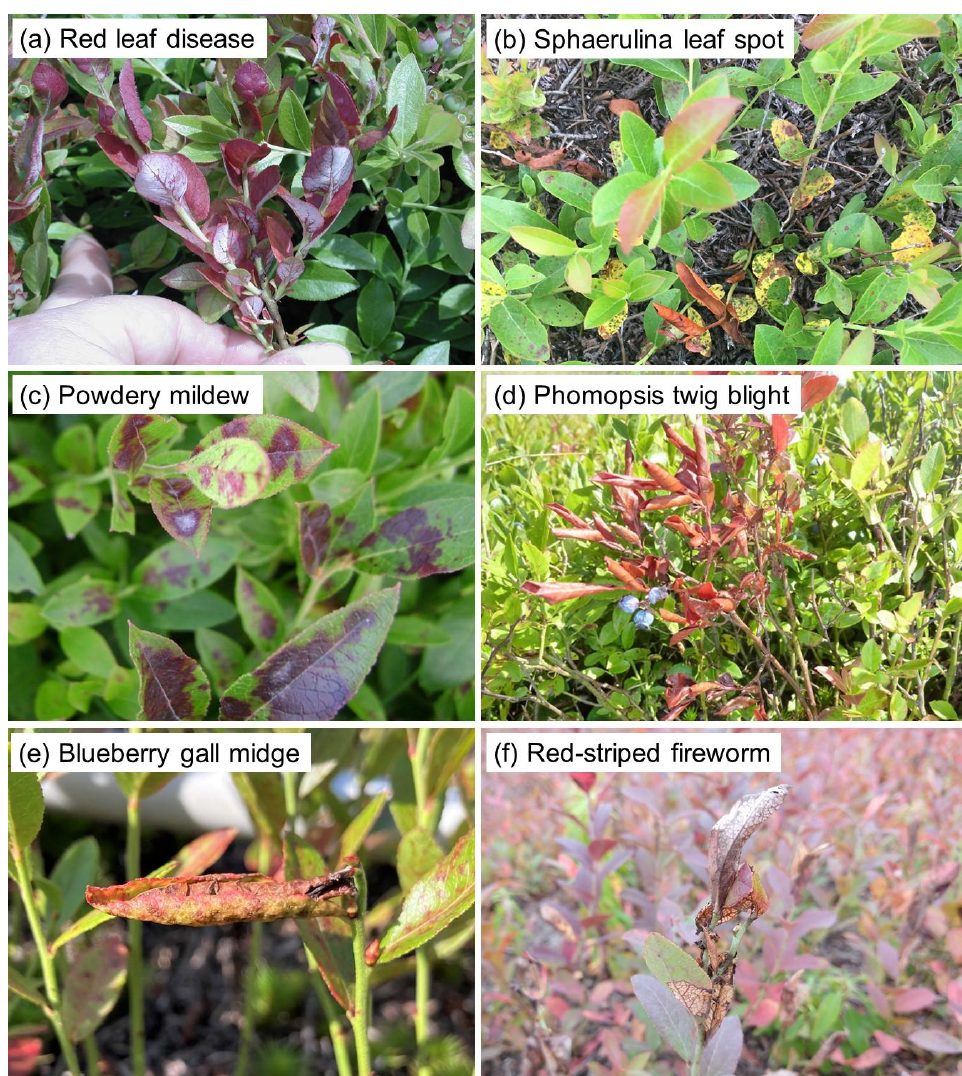
Figure 2. Symptoms of major diseases and insect pests in the wild lowbush blueberry field investigated in the present study. The photos show the typical symptoms of ( a ) red leaf disease, ( b ) Sphaerulina leaf spot disease, ( c ) powdery mildew, ( d ) Phomopsis twig blight, ( e ) blueberry gall midge, and ( f ) red-striped fireworm. Photos were taken in the field by Seanna Annis ( a – d ) and Lily Calderwood ( e , f ).